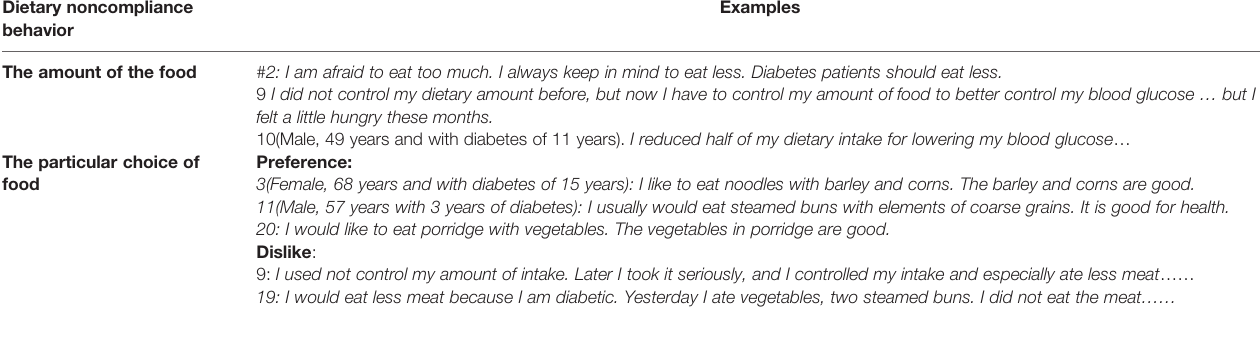
TABLE 2 | The main misconceptions according to the characteristics of the dietary noncompliance behavior. Dietary noncompliance